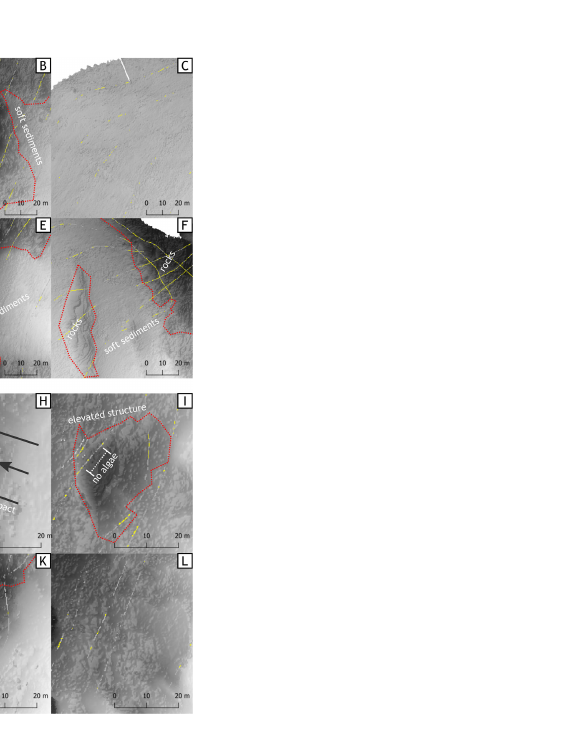
FIGURE 7 Selected close ups of algae presence along the observation routes indicated by yellow pixels (absence of algae showed in light grey) overlaid on bottom relief. Red lines indicate margins of the bed rock; arrows indicate direction of ice impact (for further explanations see text).